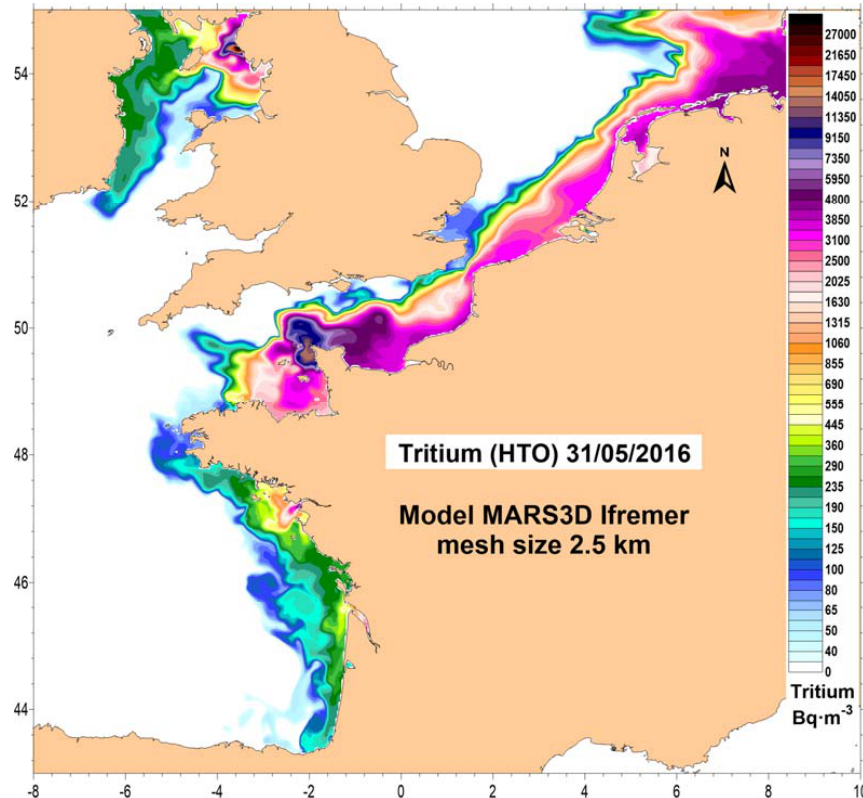
Figure 21. MARS3D simulation of the dispersion of tritium industrial releases in seawater over the European continental shelf.